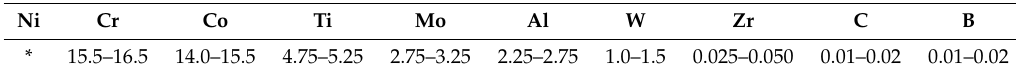
Table 2. Material composition of Udimet R (cid:13) 720 in weight